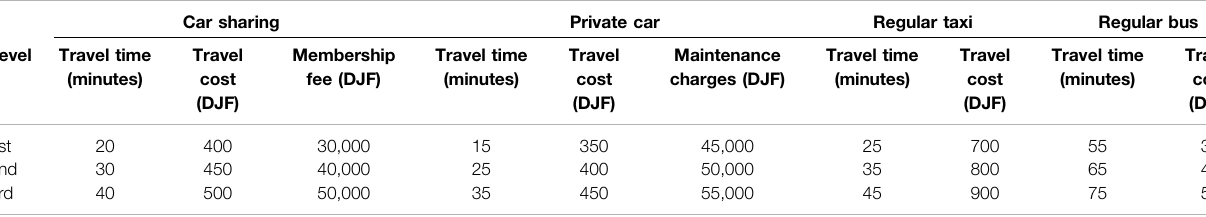
TABLE 1 | Attributes design for all four alternatives.